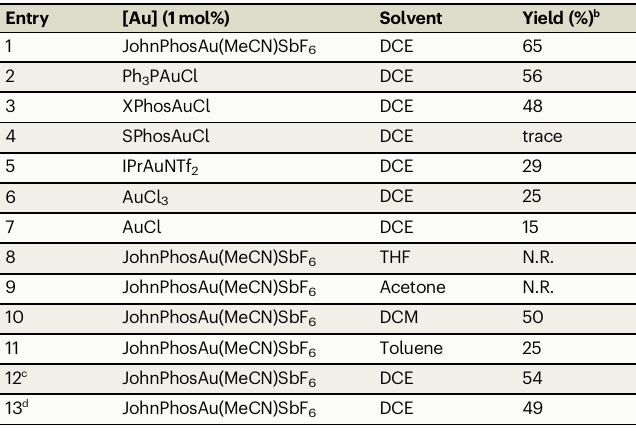
Table 1 | Optimization conditions for forming 3